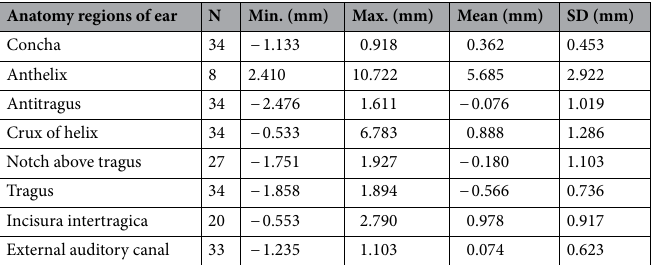
Variable Mean value of